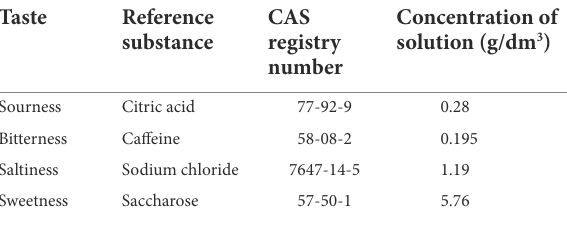
Table 1. Reagents dedicated to sensory tests of prod. Sigma- Aldrich, United States (Table